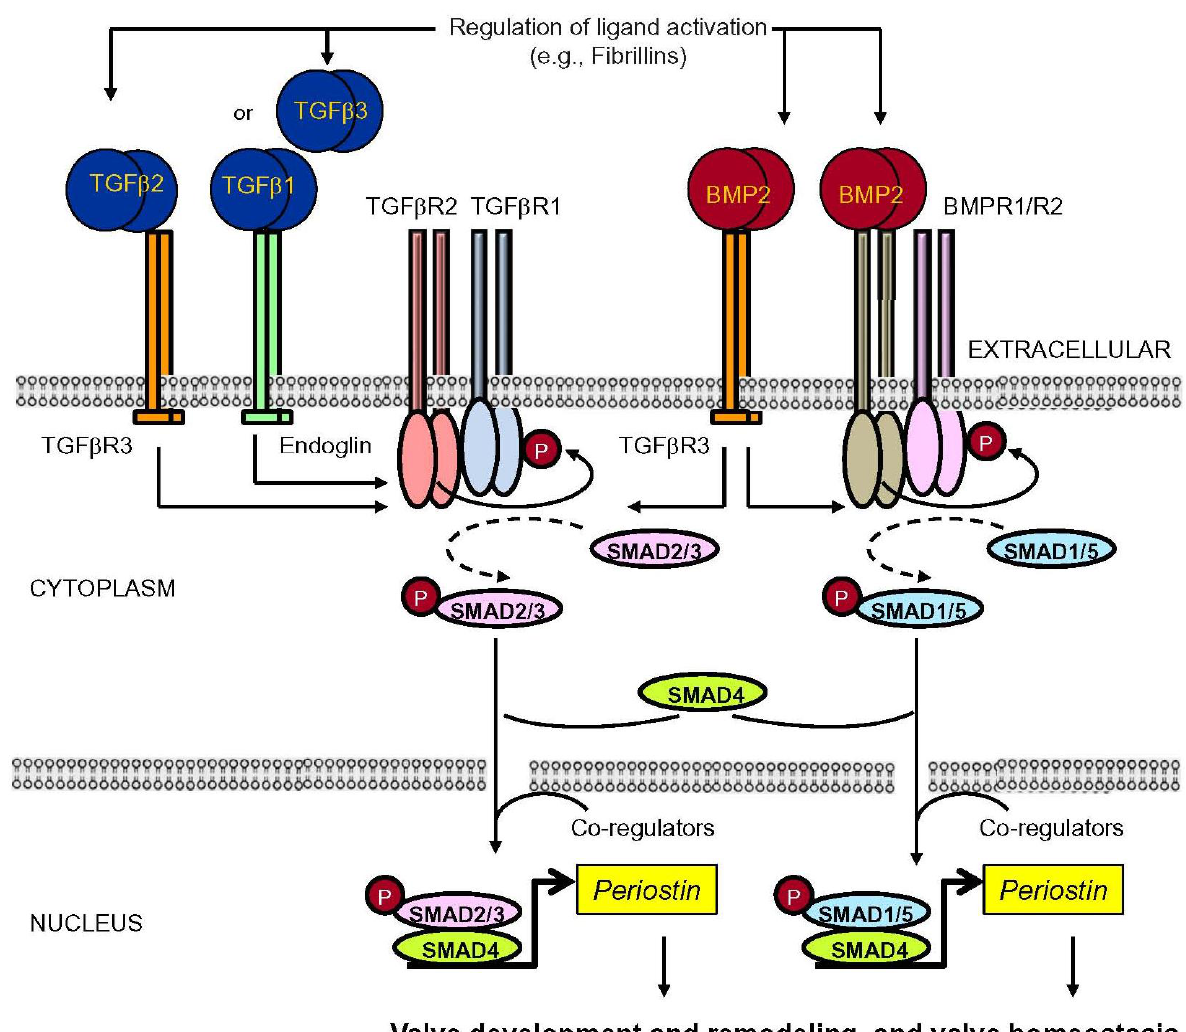
FIGURE 1. Schematic diagram illustrating the signaling events involving TGFβ, BMP, and perisotin. This association is based mostly on in vitro data and that this inter-relationship has not been completely proven in vivo . The major highlight of this illustration is that both TGF  2 and BMP2 bind to TGF  R3, and signal through the canonical TGF  signaling pathway during valve formation, which could affect periostin. ECM molecules, such as fibrillin-1, can restrict bioavailability of both TGF  and BMP ligands. In the canonical TGF  pathway, endoglin associates with TGF  1 and TGF  3 with a higher affinity than that of TGF  2. TGF  R3 is a high-affinity receptor of TGF  2. Both endoglin and TGF  R3 facilitates ligand binding to the canonical TGF  -receptor (TGF  R1/TGF  R2) heteromeric complex. This results in phosphorylation of the TGF  -specific SMADs (i.e., pSMAD2/3). The pSMAD2/3 forms a complex with SMAD4, which accumulates in the nucleus and can regulate Postn . Canonical BMP2 signaling occurs through BMP receptors and BMP-specific SMADs (i.e., SMAD1/5/8). BMP signaling has also been shown to induce Postn . Based on the individual activities of TGF  , BMPs, and periostin in valvulogenesis, it is likely that this inter-relationship may play an important role in valvular heart diseases. See the text for more